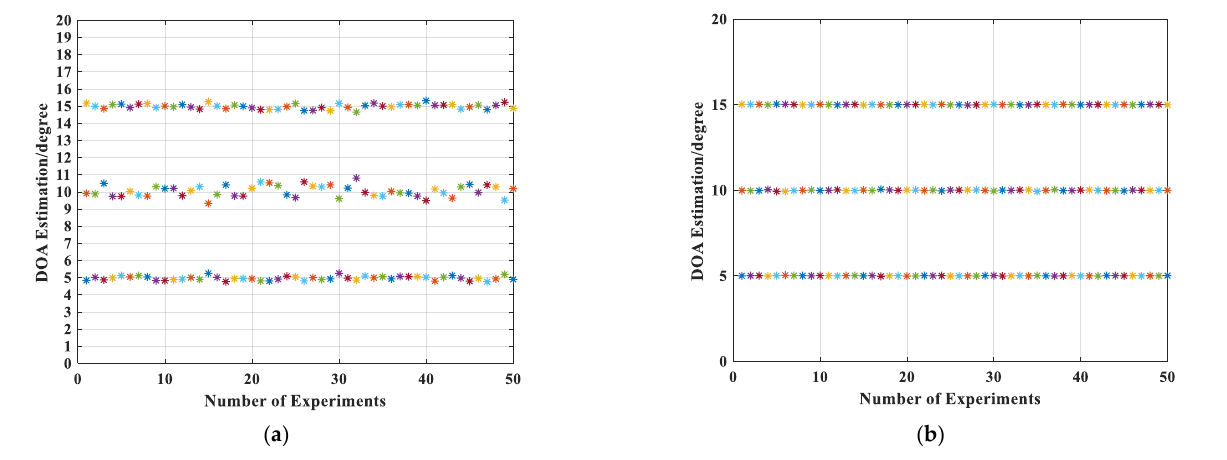
Figure 4. Coherent DOA estimation results over 50 trails in Case 2. ( a ) SNR = 0 dB; ( b ) SNR = 20 dB.